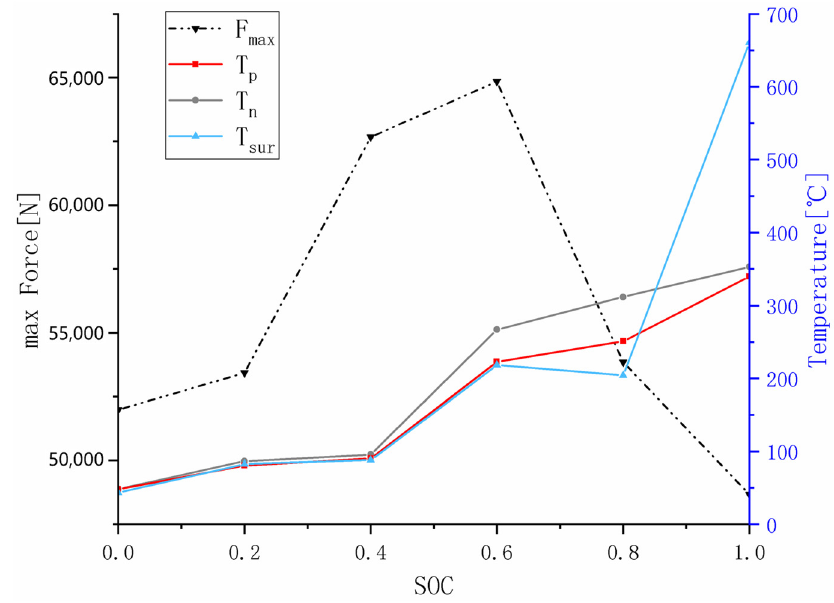
Figure 22. Different SOC peak loads and peak temperatures.